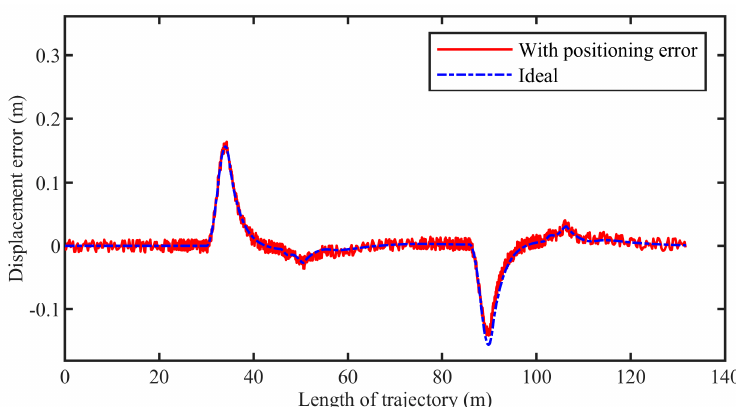
Figure 21. Articulated angle speed of the simulation with positioning errors.